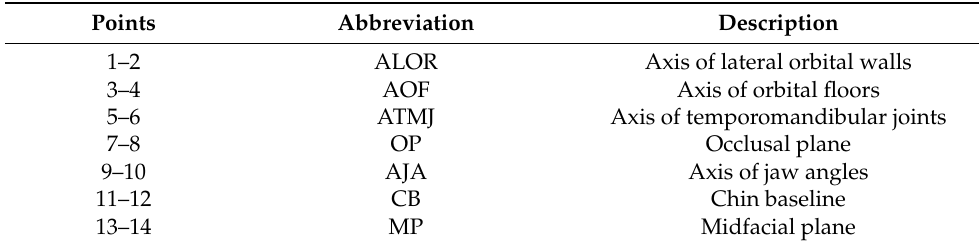
Figure 7. Radiological landmarks and axes as described in Table 3 Error! Reference source not found. . Ideally the vertical (MP) should be perpendicular to all six axes axis of lateral orbital walls (ALOR), axis of orbital floors (AOF), axis of temporomandibular joints (ATMJ), occlusal plane (OP), axis of jaw angles (AJA), and chin base (CB). Table 3. Axes between two defined points (see Figure 1). Six angles between each axis and the midfacial plane are determined.